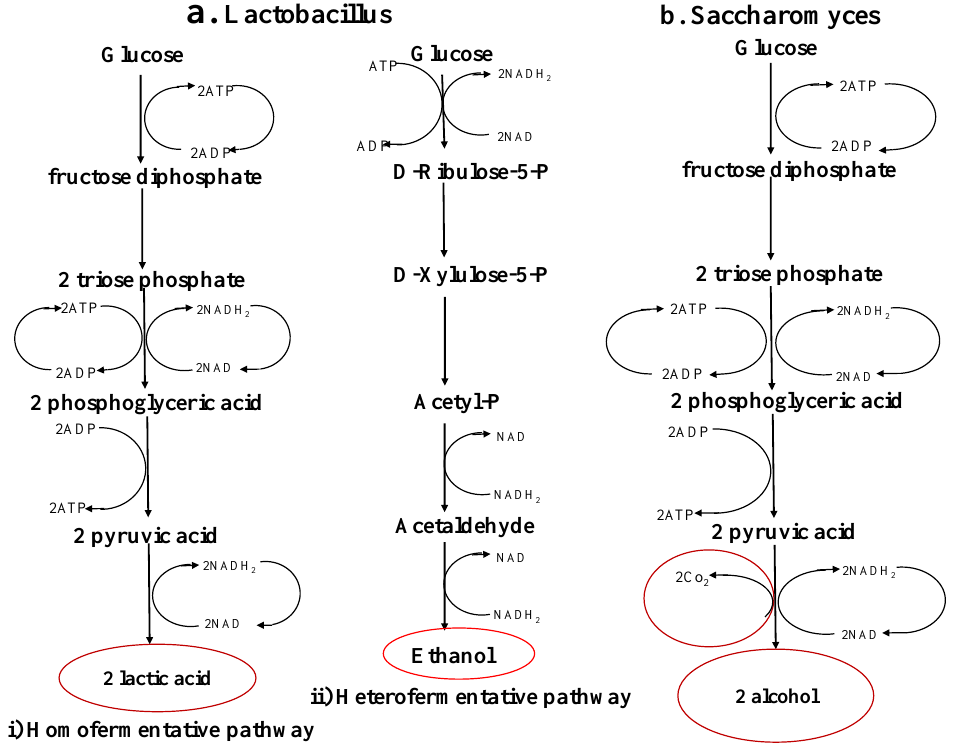
Figure 1. Sugar metabolism by Lactobacillus and Saccharomyces as representatives of L.A.B. and yeasts [11,12].